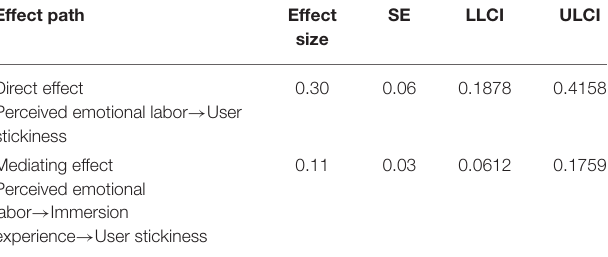
TABLE 3 | Bootstrap effect analysis.